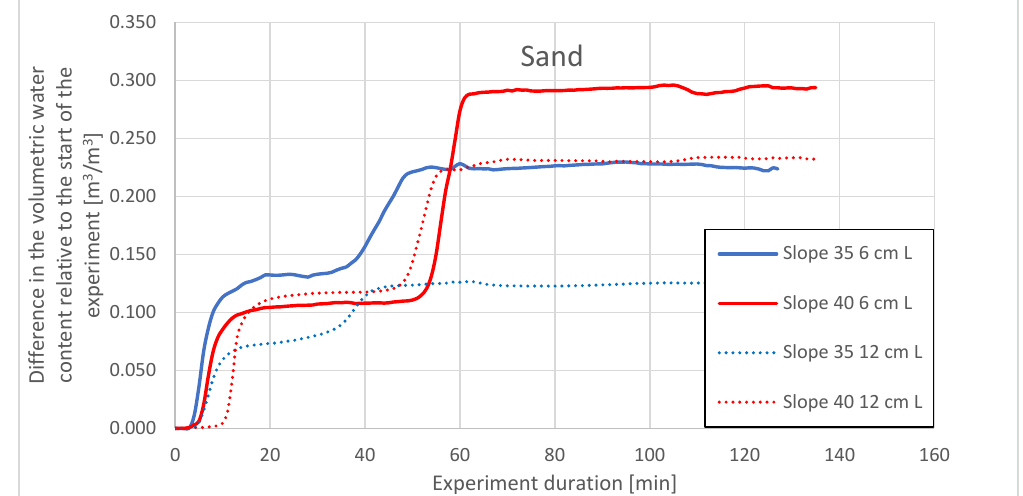
Figure 9. Comparison of the changes in the volumetric water content at different parts of the experimental model for the Sand experiment. Locations of measurement points are shown in Figure 2.